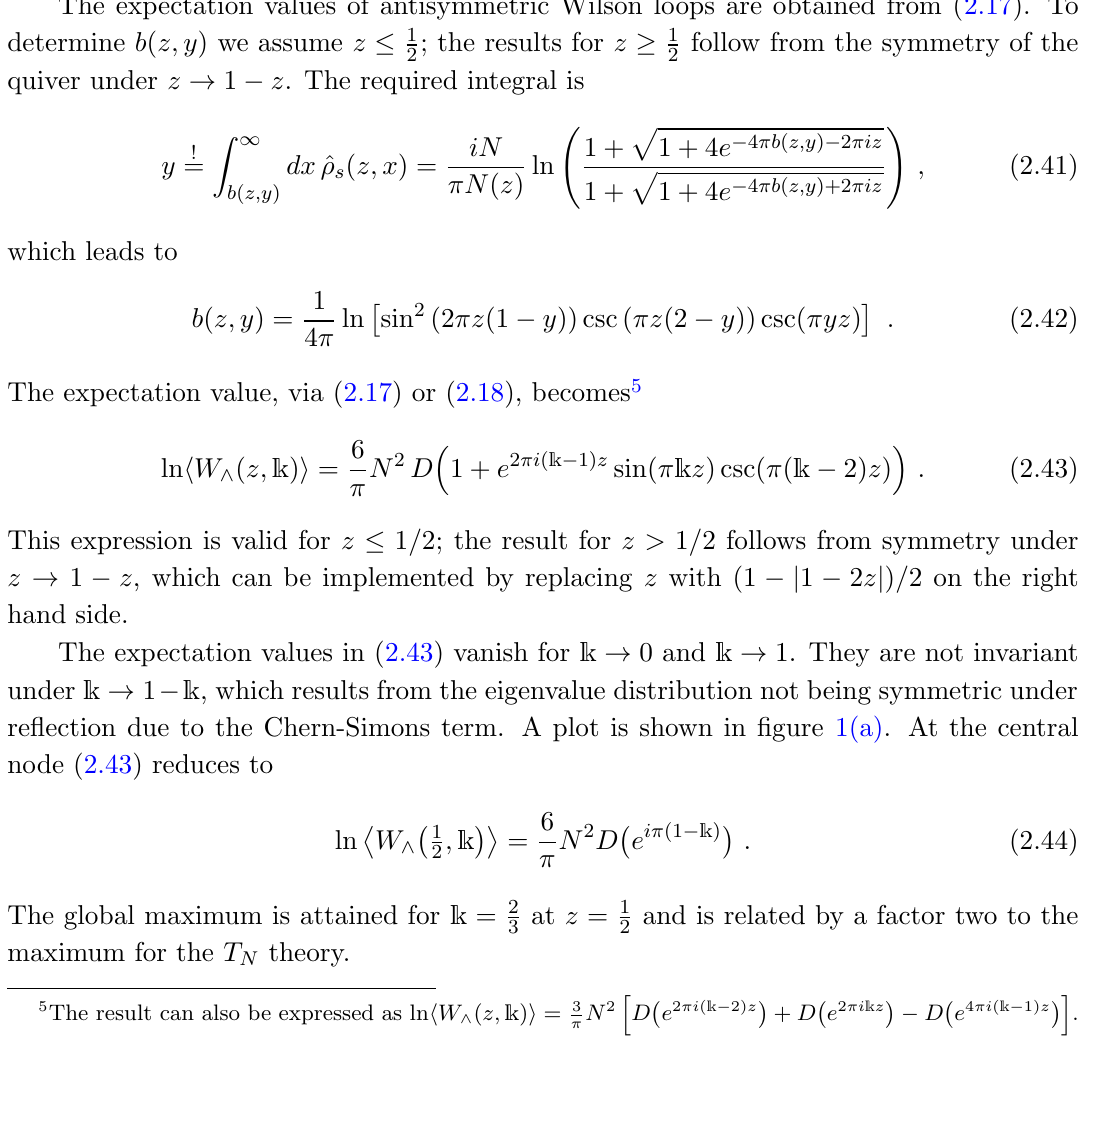
Figure 1 . Left: expectation value of the ^ k Wilson loop in the Y N theory. The dashed curves from bottom to top are for z 2 the X N